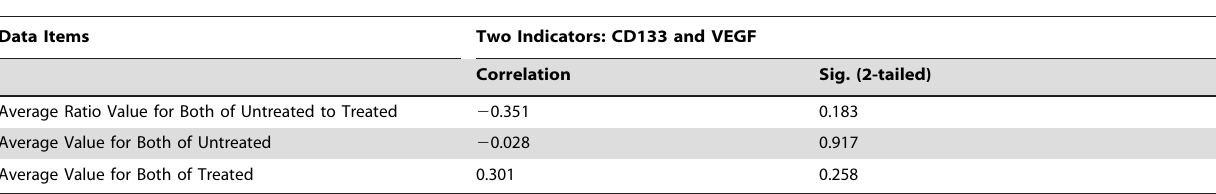
Table 3. Association Analysis Between Two Indicators, CD133 mRNA and VEGF Value*.